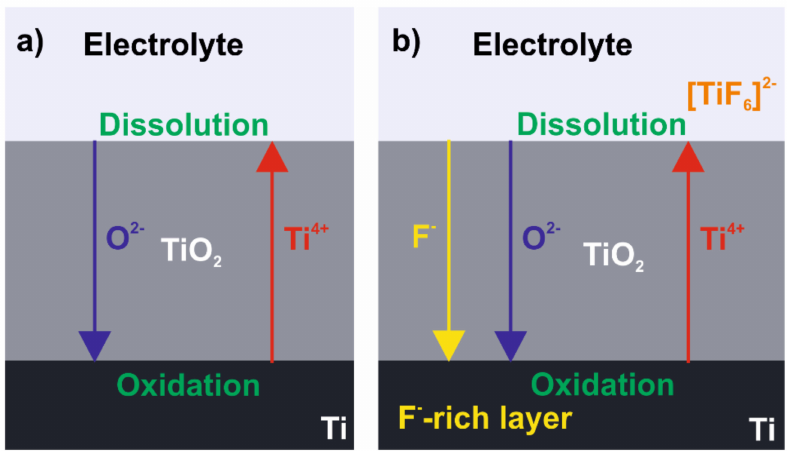
Figure 8. Schematic representation of oxide layer formation on titanium during anodization in ( a ) electrolyte without addition of fluoride ions and ( b ) fluoride ions containing